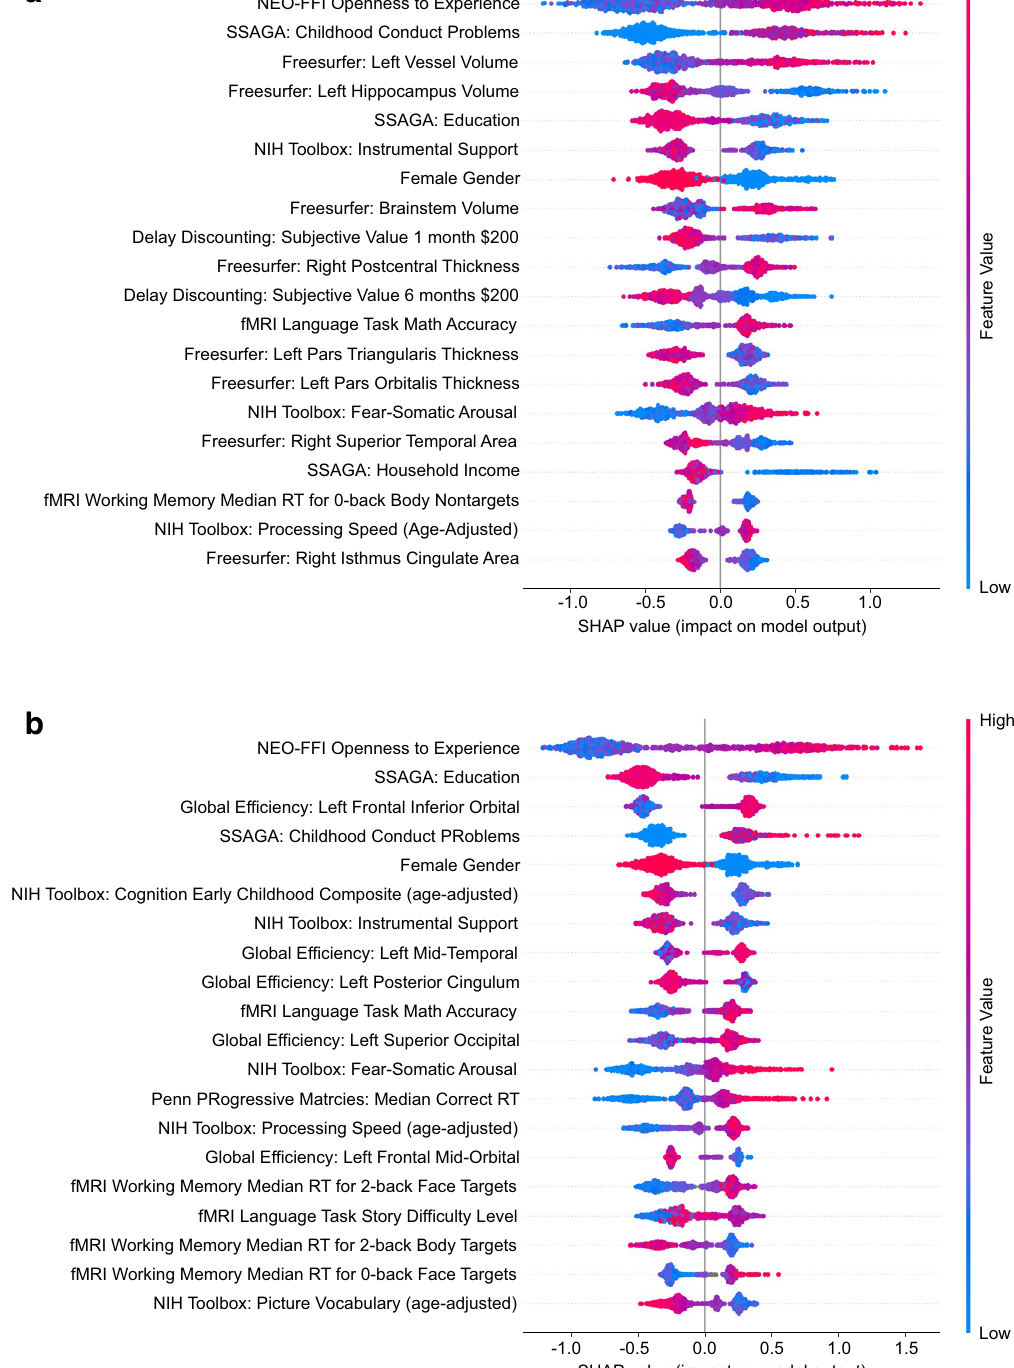
Figure 2. SHAP ranking for factors contributing to the two bimodal models ( a : phenotypic + Freesurfer, b : phenotypic + global efficiency) classifying cannabis dependence. Higher positive SHAP values on the x-axis indicate that the observed factor pushed the classification closer towards cannabis dependence, whereas more negative SHAP values indicate that the factor pushed the classification away from cannabis dependence. Factors are ranked in order of the average (absolute) SHAP value, which indicates the importance of a factor. Individual data points (dots) represent the model output for each individual in the sample. The position of a dot on the x-axis represents the impact of the observed factor on the model output for the individual. The color of the individual dots represent the value of the observed measurements, with blue indicating lower and red higher values (e.g. red indicates high openness or high education level in these plots). As an example, in both plots high (red dots) observed “Openness to Experience” and low (blue dots) education levels pushed the model prediction closer towards cannabis dependence. That is, high “Openness to Experience” and lower education levels make it more likely that the model would categorize a given individual as cannabis-dependent relative to not